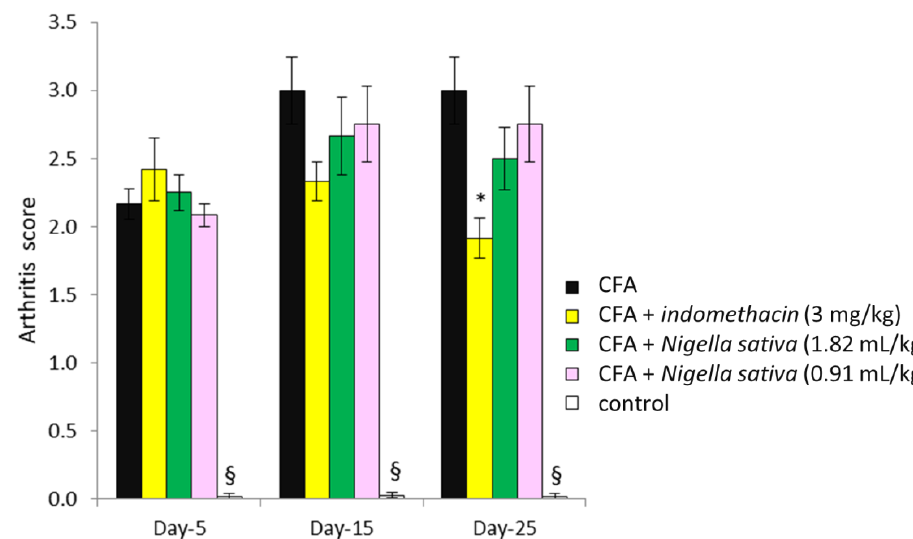
/ kg), indomethacin (3 mg / kg) or